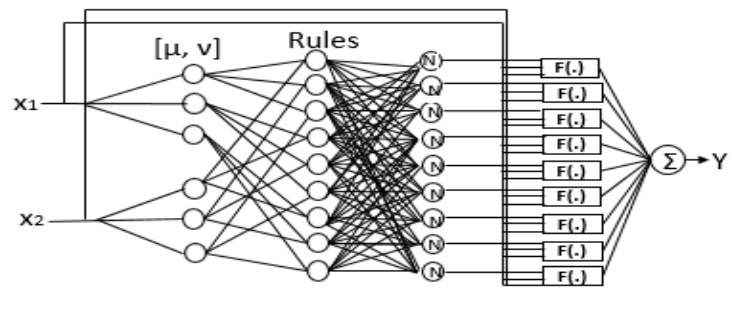
Fig. 3. Architecture of IFLS